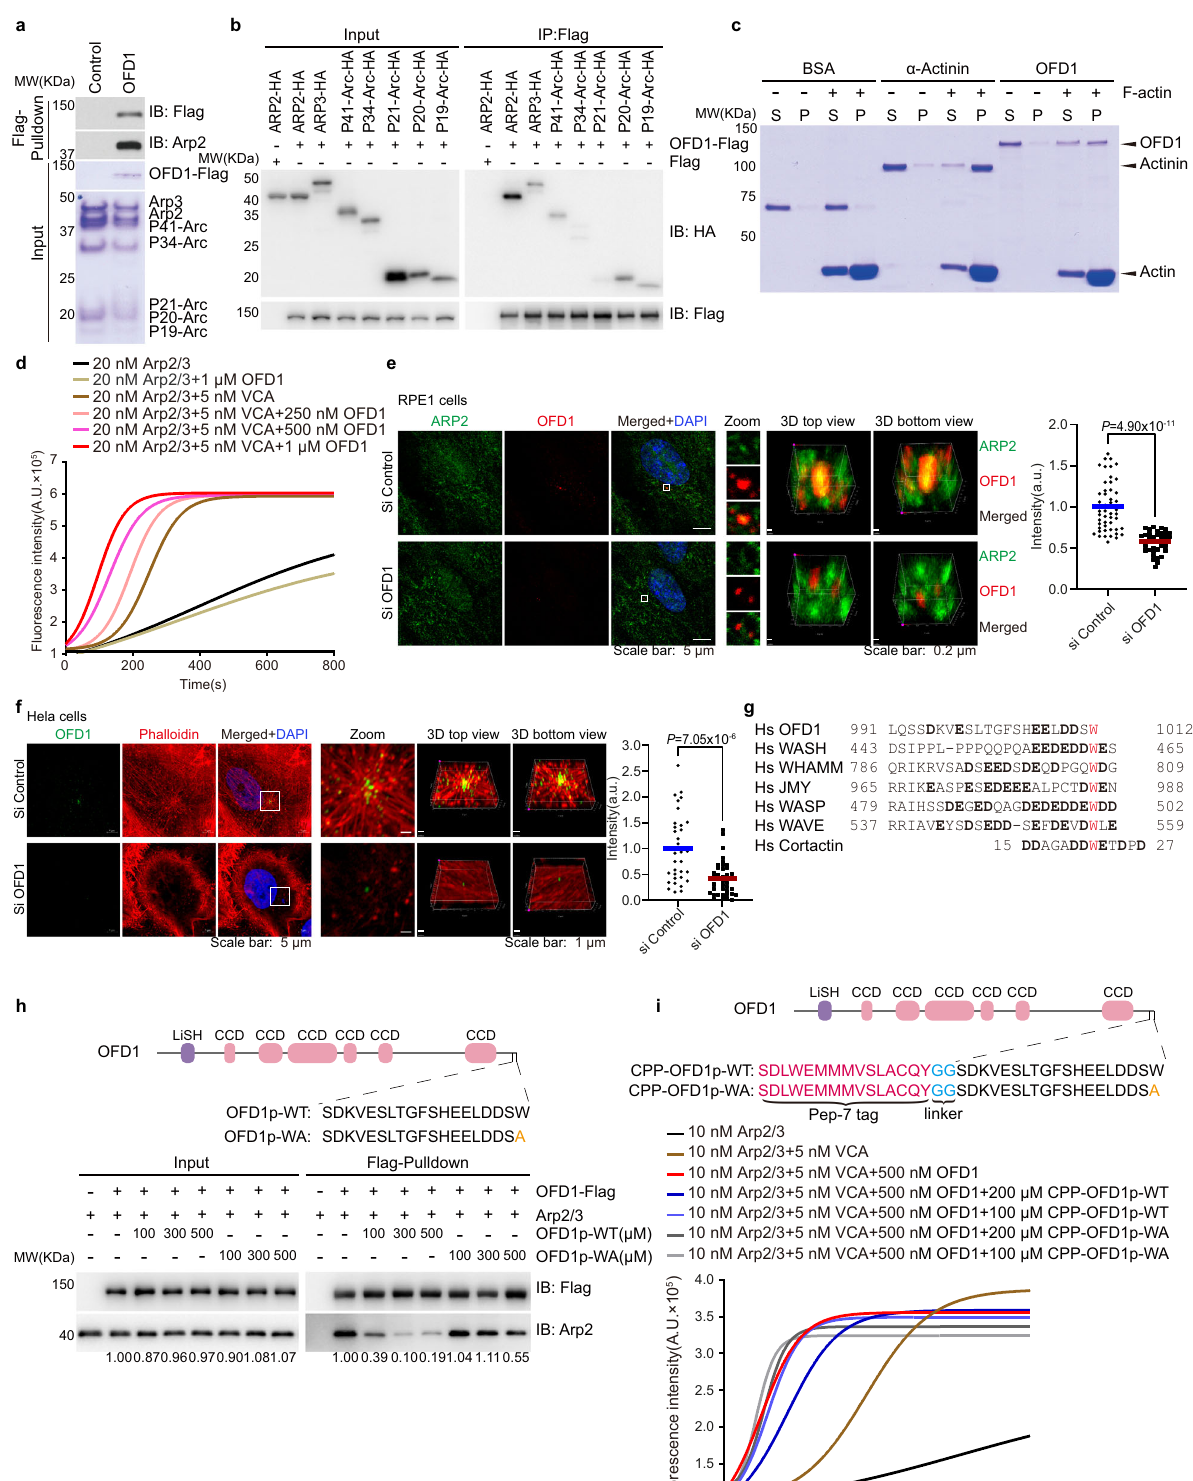
linkerSDLWEMMMVSLACQYGGSDKVESLTGFSHEELDDSW SDLWEMMMVSLACQYGGSDKVESLTGFSHEELDDSA { Pep-7 tag